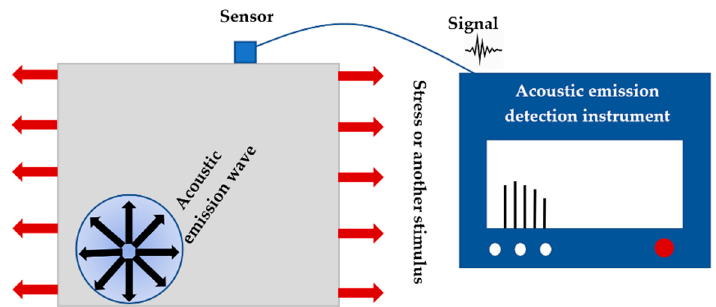
Figure 1. Basic acoustic emission (AE) data acquisition system for concrete